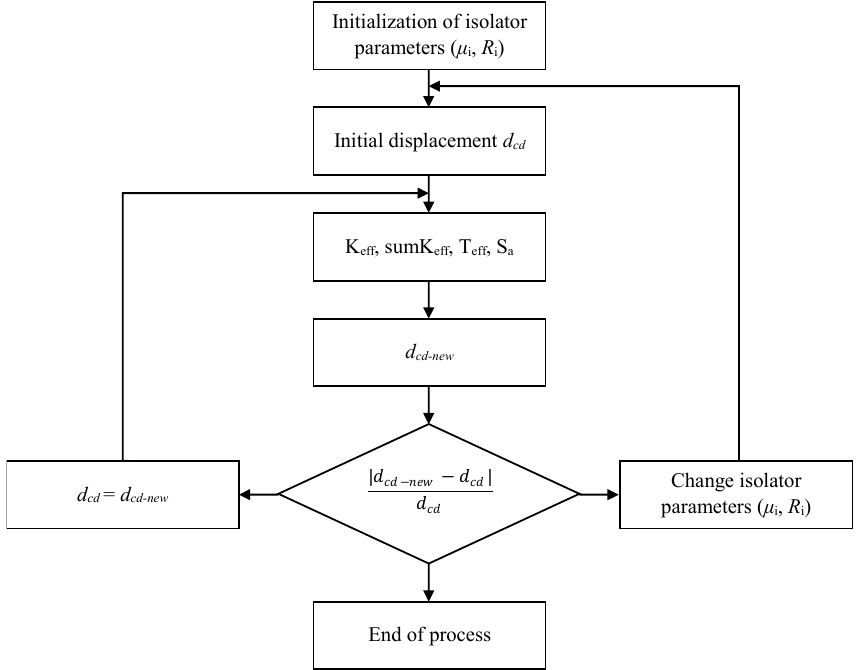
Figure 6. Flowchart of the conventional ELF design process for single (SFPB1) and triple (TFPB1) isolators.